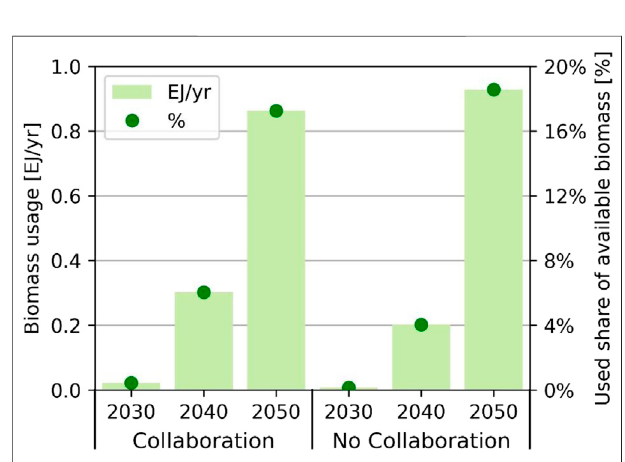
FIGURE 3 | The amounts of biomass (left axis) used in the modelled region in the two scenarios in Years 2030, 2040 and 2050, and including (right axis) this usage as a percentage of the estimated sustainable biomass in the